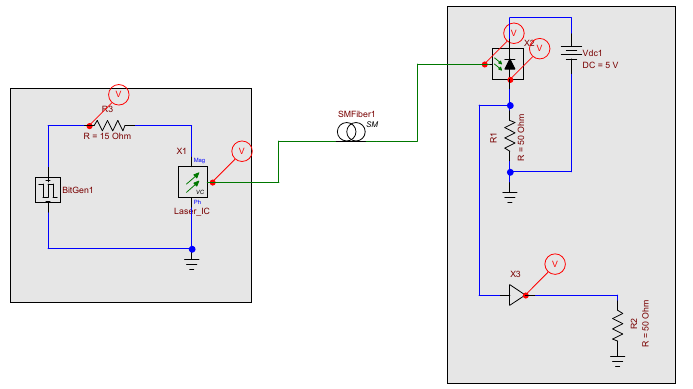
Figure 10. OptiSpice schematic for an optical sensor.